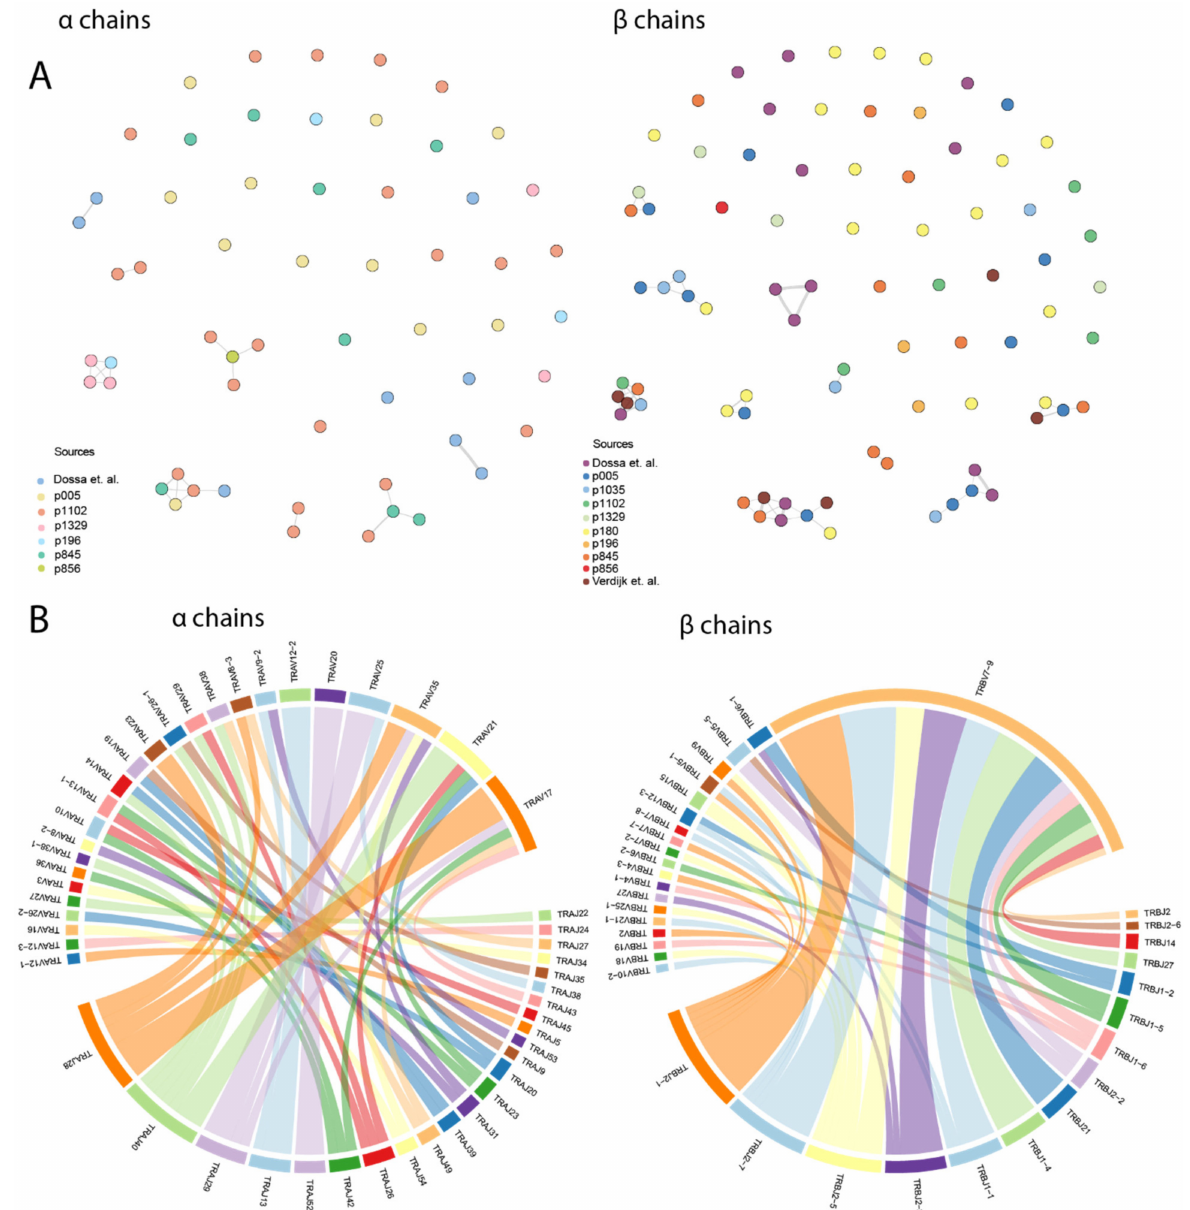
Figure 2. Bioinformatic analysis revealed the low degree of CDR3 similarity and the bias in usage of TRBV7-9 gene in the HA-1-specific TCR repertoire ( A ) Levenshtein distances between the CDR3 amino acid sequences of HA-1-specific TCR α and β chains. Each chain is represented by colored circle, connecting lines represent 1–3 amino acid substitutions. ( B ) Frequency analysis of V and J gene usage showed that TRBV7-9 is overrepresented in the repertoire of β chains, whereas V genes in the α chain repertoire are more equally distributed. Entanglement analysis did not reveal any bias in the V and J genes pairing